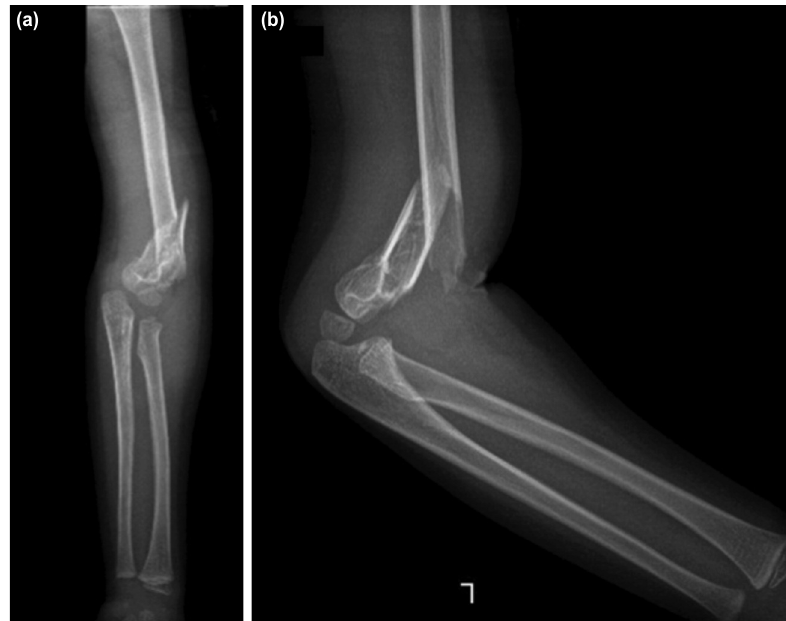
(a) Initial post-traumatic anteroposterior and (b) lateral radiographs of the left elbow showing ipsilateral fracture of the distal Fig. 1: shaft humerus and supracondylar with complete displacement.